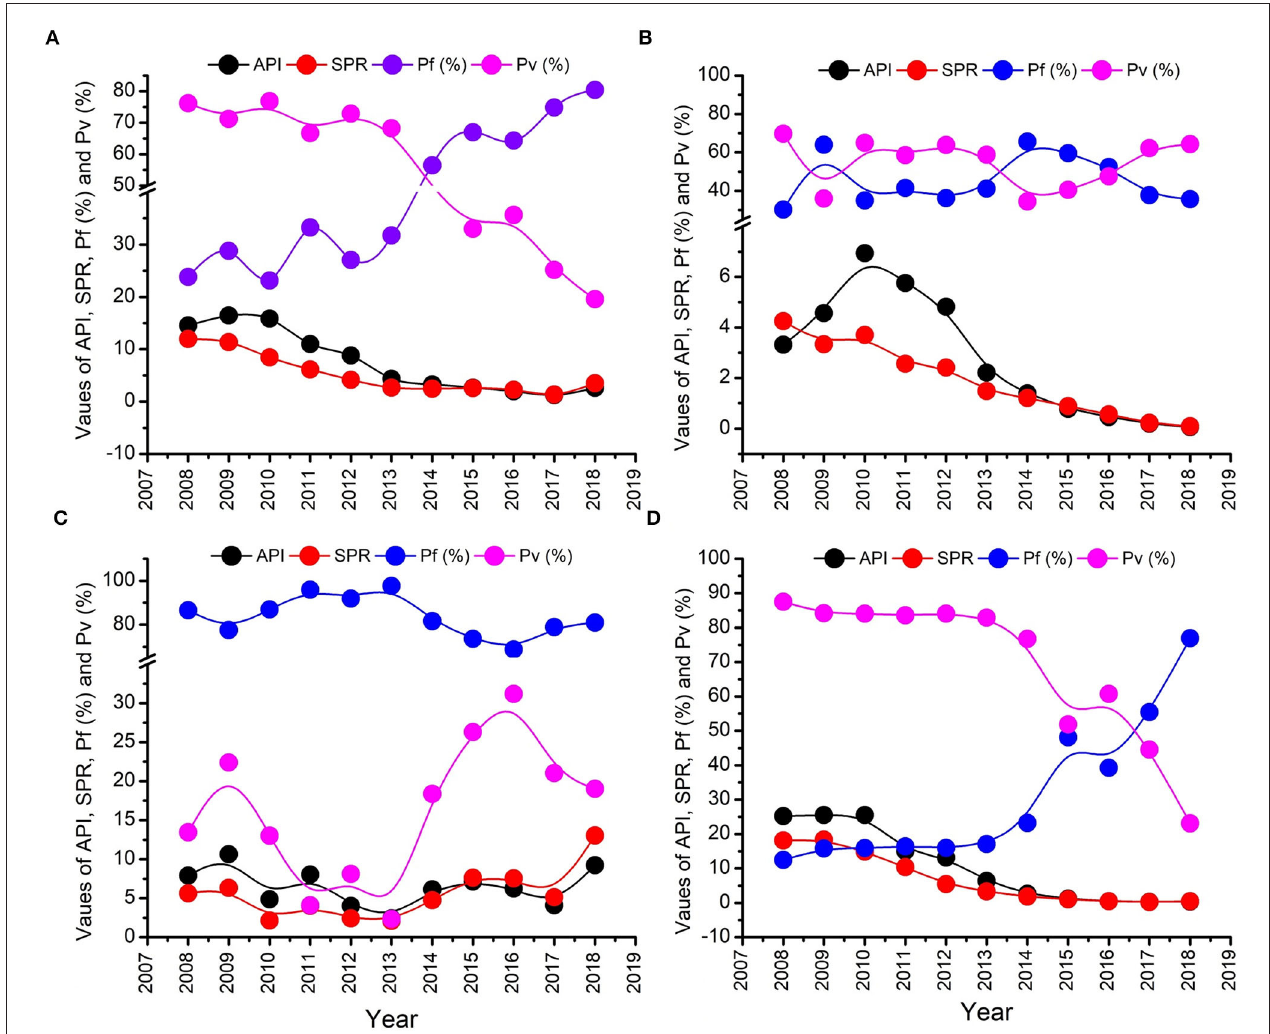
FIGURE 2 | Malaria epidemiological trend from 2011 to 2018. (A) Entire Udalguri district, (B) Khoirabari BPHC, (C) Orang BPHC, and (D) Udalguri